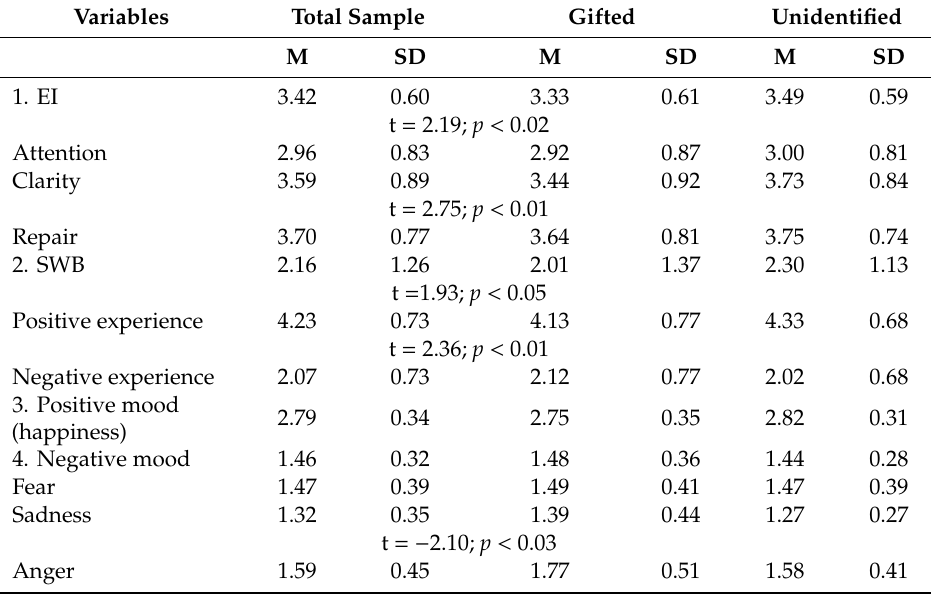
Table 1. Descriptive statistics and t